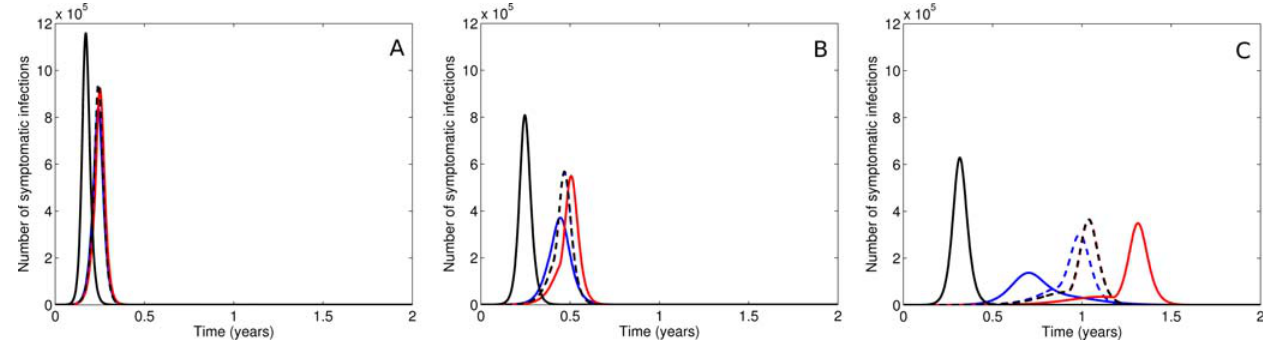
Figure 4. The impact of seeding and fitness on viral dynamics. Epidemic curves. No intervention (solid black), no resistance (dashed black), high fitness (blue) with high seeding (solid) and low seeding (dashed) and low fitness (red) with high seeding (solid) and low seeding (dashed). a. Epidemic curves for high/low seeding and high/low fitness and a =0.5. The intervention has a marginal effect for all combinations of resistant virus strain properties. b. Epidemic curves for high/low seeding and high/low fitness and a =0.6. The intervention has a small effect. High fitness resistant strains (blue) result in a marginally shorter time to epidemic peak than in the case of a low fitness resistant strain or no emergence of resistant strains. c. Epidemic curves for high/low seeding and high/low fitness and a =0.7. The intervention has a significant impact on the dynamics. For high fitness (blue), the resistant strain can dominate and dramatically lessen the time to epidemic peak. For low fitness, the epidemic is well controlled until stockpile expiry. A high seeding rate (solid red) provides an ‘‘immunising effect’’ which results in a dramatic delay in time to median infection.